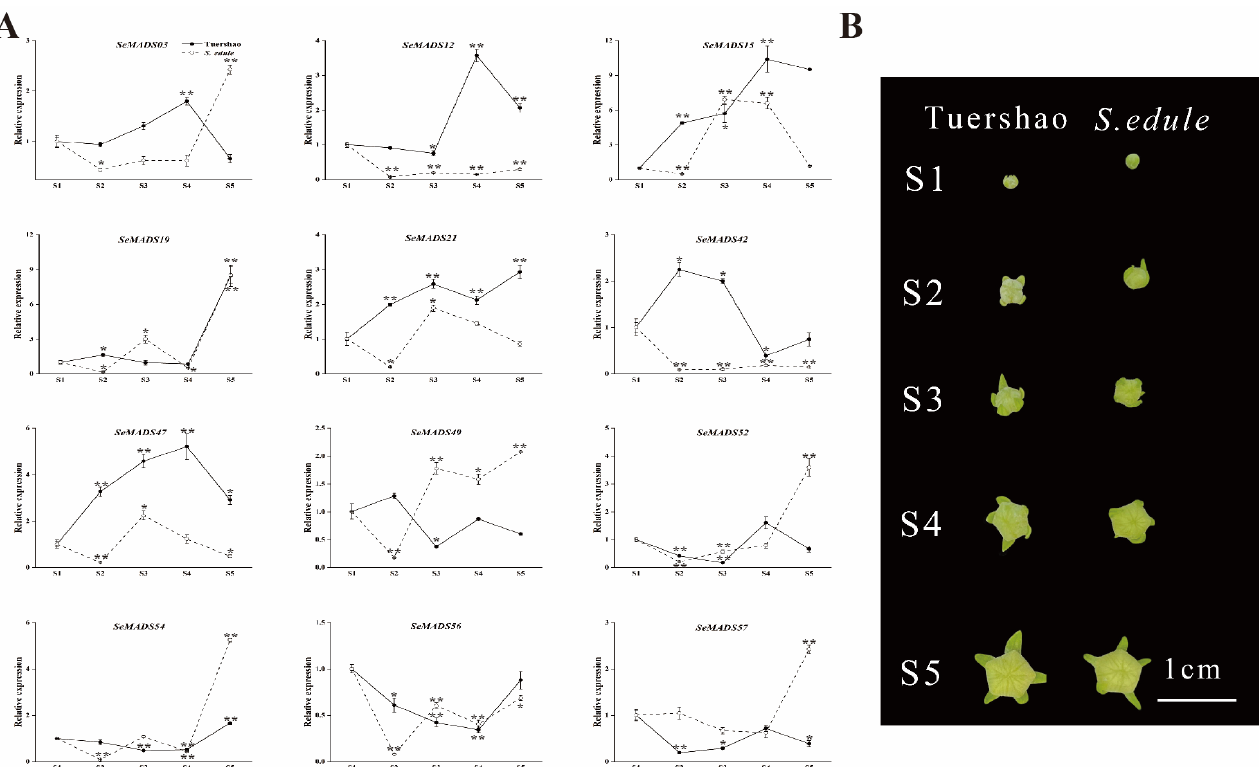
Figure 10. Comparison of expression patterns of the SeMADS-box at different male flower develop- ment stages in ‘Tuershao’ and S. edule . ( A ) SeMADS-box gene expression pattern. ( B ) Male flowers at different development stages. Asterisks represent the significant difference at the same developmental stage point (* p < 0.05; ** p < 0.01).